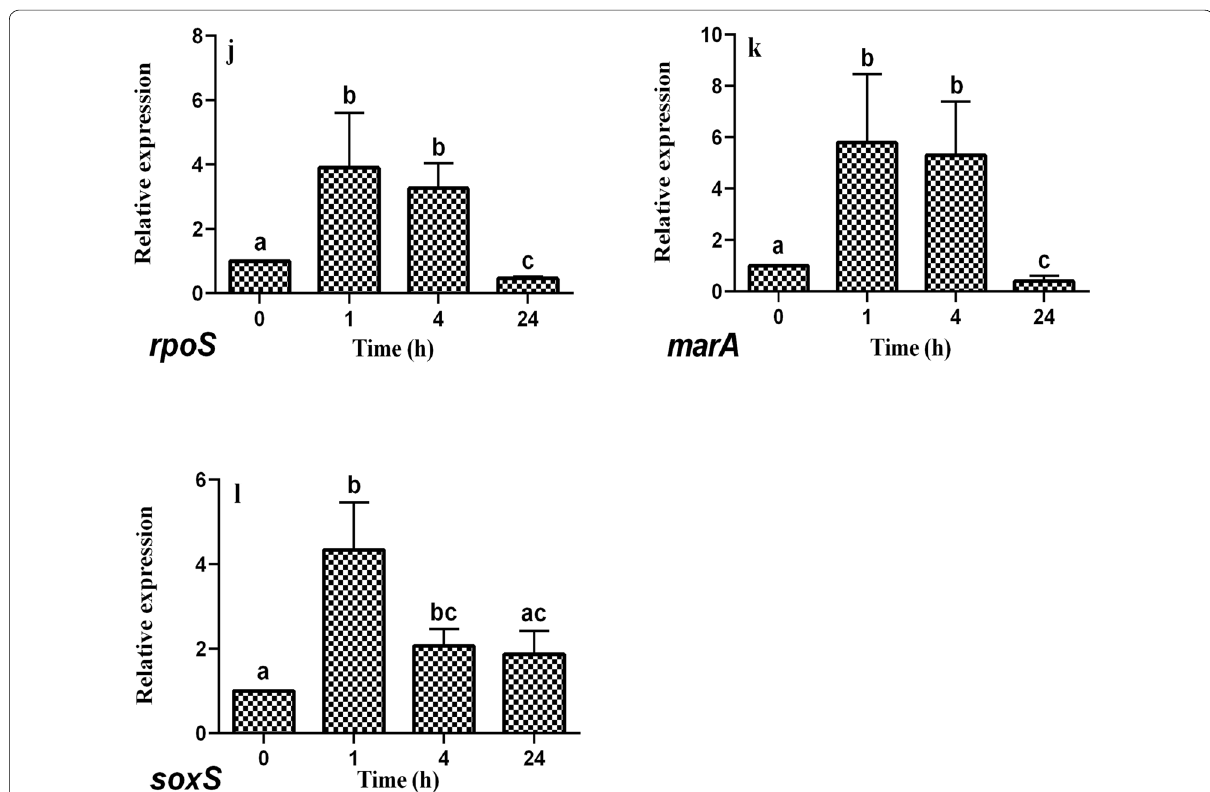
Fig. 5 Relative expression of genes related to stress response of E. coli CFT073 exposed to dithiocyano-methane. Different small letters indicate significant differences in exposed group among different times (P < 0.05), and bars represent standard deviations of the